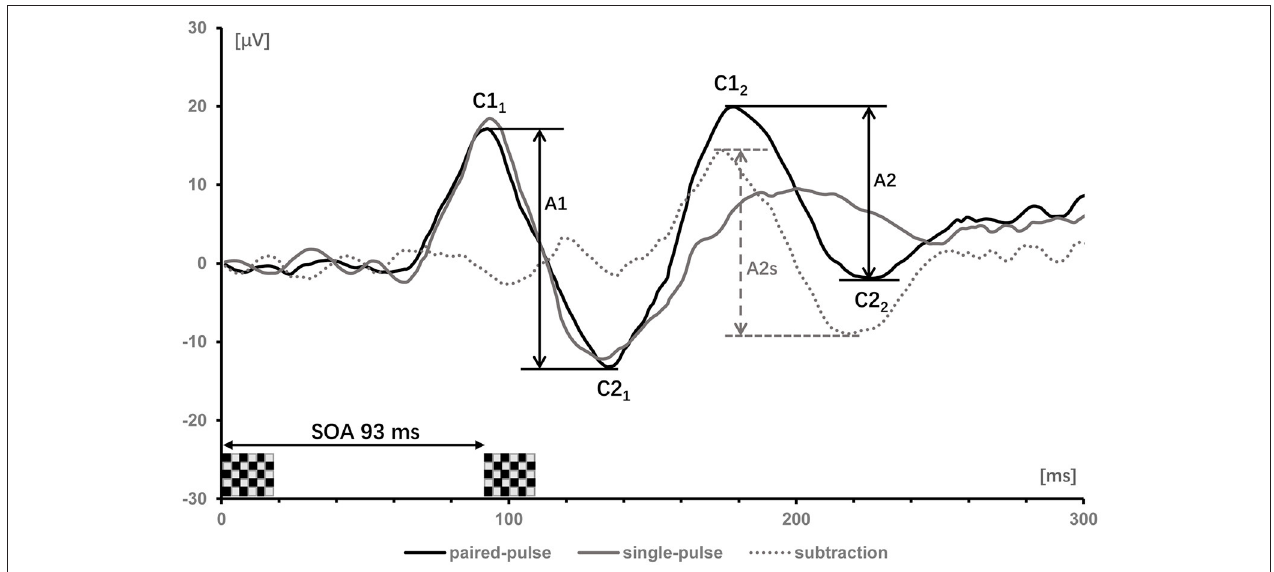
FIGURE 1 | Visually evoked potentials of one subject after single- (gray trace) and paired-pulse with SOA of 93ms (black trace). The label C denoted the positive and negative components of the first and second response. Subtracting the single-pulse trace from the paired-pulse trace yields the dotted gray trace. The first amplitudes (A1 = C2 1 -C1 1 ) and second amplitudes (A2 = C2 2 -C1 2 ) in the paired-pulse trace are indicated by vertical bars; the second amplitudes (A2) after subtracting the response of a single-pulse are denoted as A2s.